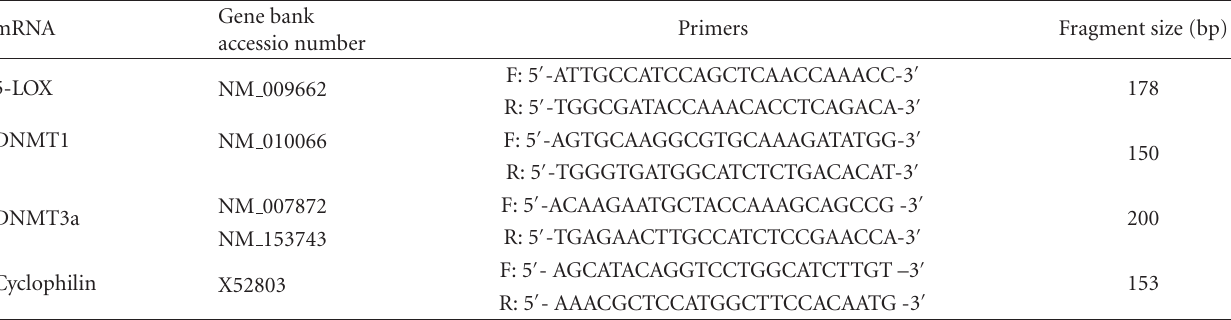
Table 1: Primer sequences used to assay 5-LOX, DNMT1, DNMT3a, and cyclophilin (reference)